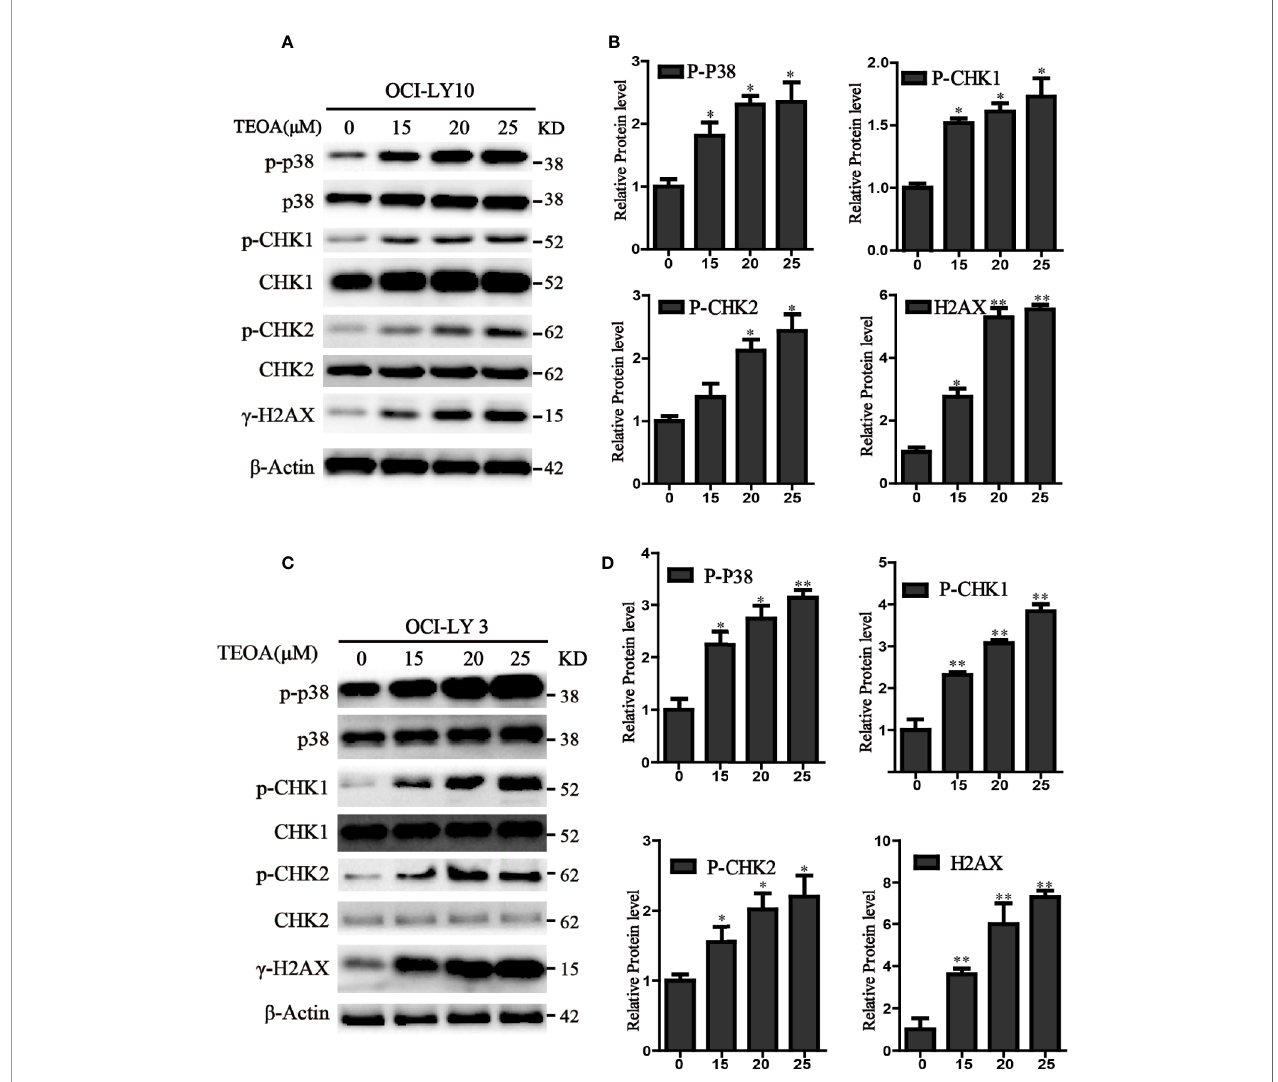
FIGURE 5 | TEOA induced DNA damage in diffuse large B-cell lymphoma (DLBCL) cells. (A, C) OCI-LY10 and OCI-LY3 cells were treated with TEOA for 12 h and then subjected to western blot with staining for p-p38, p38, p-CHK1, CHK1, p-CHK2, CHK2, and g -H2AX. (B, D) Analysis of the expression of p-p38, p-CHK1, p-CHK2, and g -H2AX by Image J software. Data were presented as mean ± SD, * P <0.05, ** P